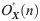
C and O state-dependent binding probabilities for different concentrations of sevoflurane at the reservoir.(A) Marginal probabilities ρX(nj) of site j, for nj = 0 (gray), nj = 1 (blue) and nj = 2(cyan). Marginals at the extracellular face of the channel are negligible for every structure/concentration. (B) Probabilities ρX(n) for macrostates OX*(n) mapping an ensemble of accessible states OX*(n1,…,ns) in which n ligands bind the receptor regardless their specific distributions over the binding sites. Here, ρX(nj) and ρX(n) were computed by coarse-graining over state probabilities in S4 Fig (cf. Computational Methods for details). Average number ⟨nX⟩ of bound ligands as a function of the reservoir concentration is indicated in (B).